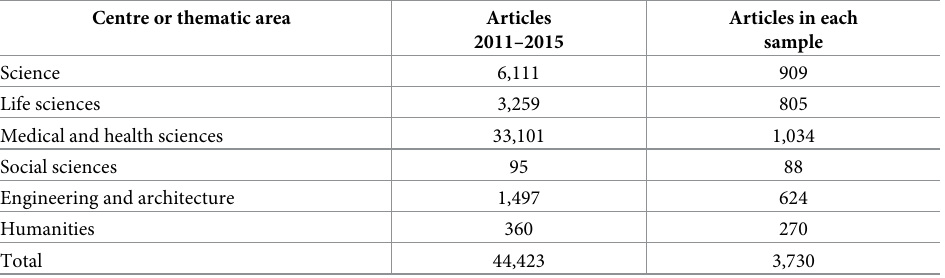
Table 1. Articles by thematic area published by CERCA centres 2011–2015 and number of articles included in the six samples. Centre or thematic